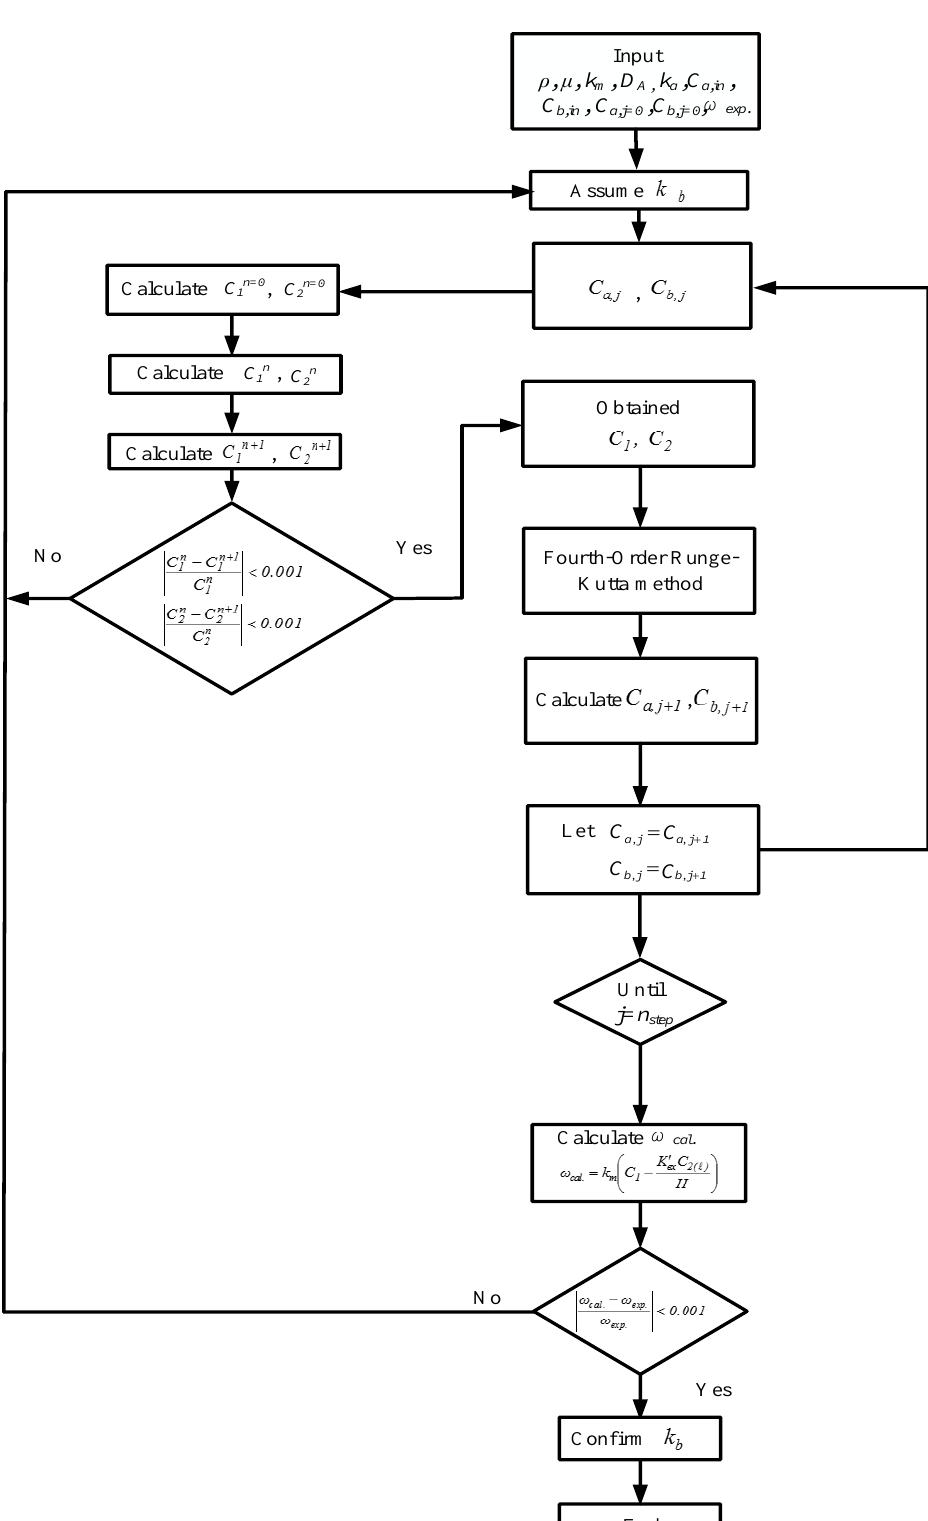
Figure 7. Calculation flow chart for determining CO 2 concentrations in gas and liquid phases under concurrent-flow operations.